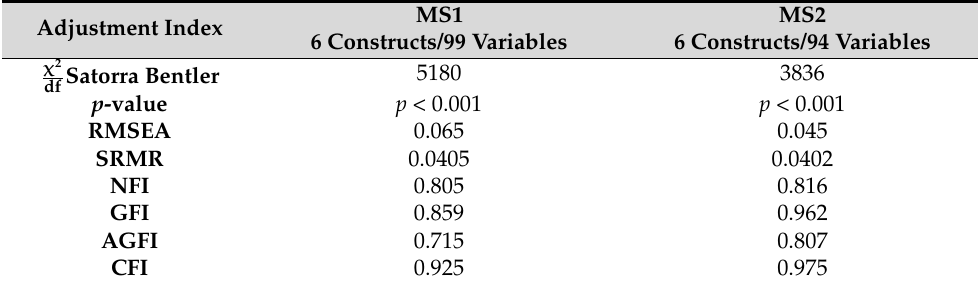
Table 2. Quality index of the adjustment of the models